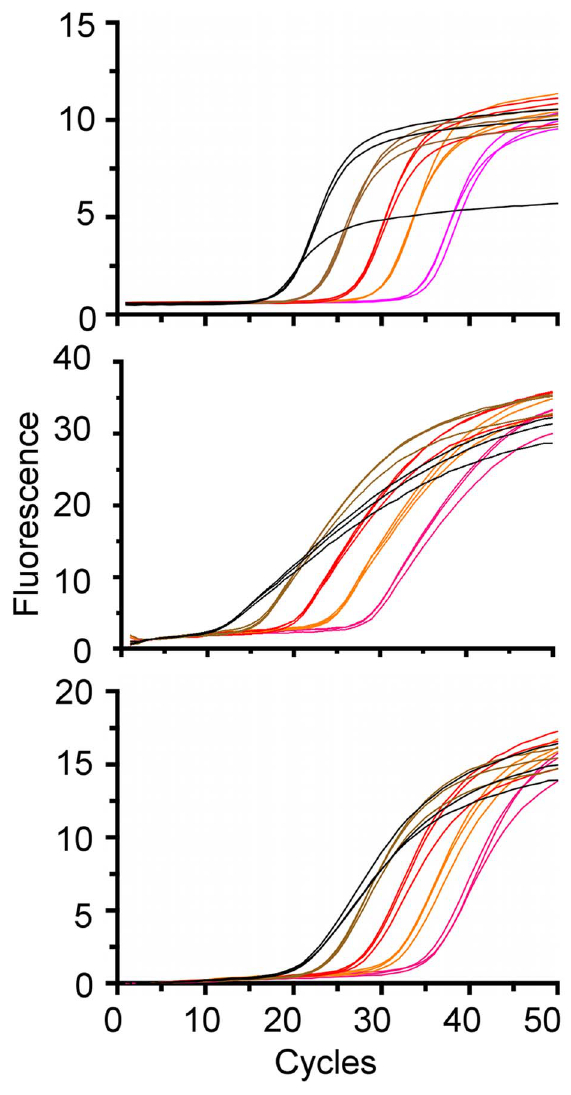
Figure 3. Fluorescence as a function of reaction cycles for (A) chicken, (B) Canissp. and (C) human. Positive controls were run in triplicate starting with 10 0 on the left (black) followed by each successive 10-fold serial dilution in a different color. Amplification curves are shown for the dilutions above the 10 2 4 limit at which template concentration that can be detected with 95%